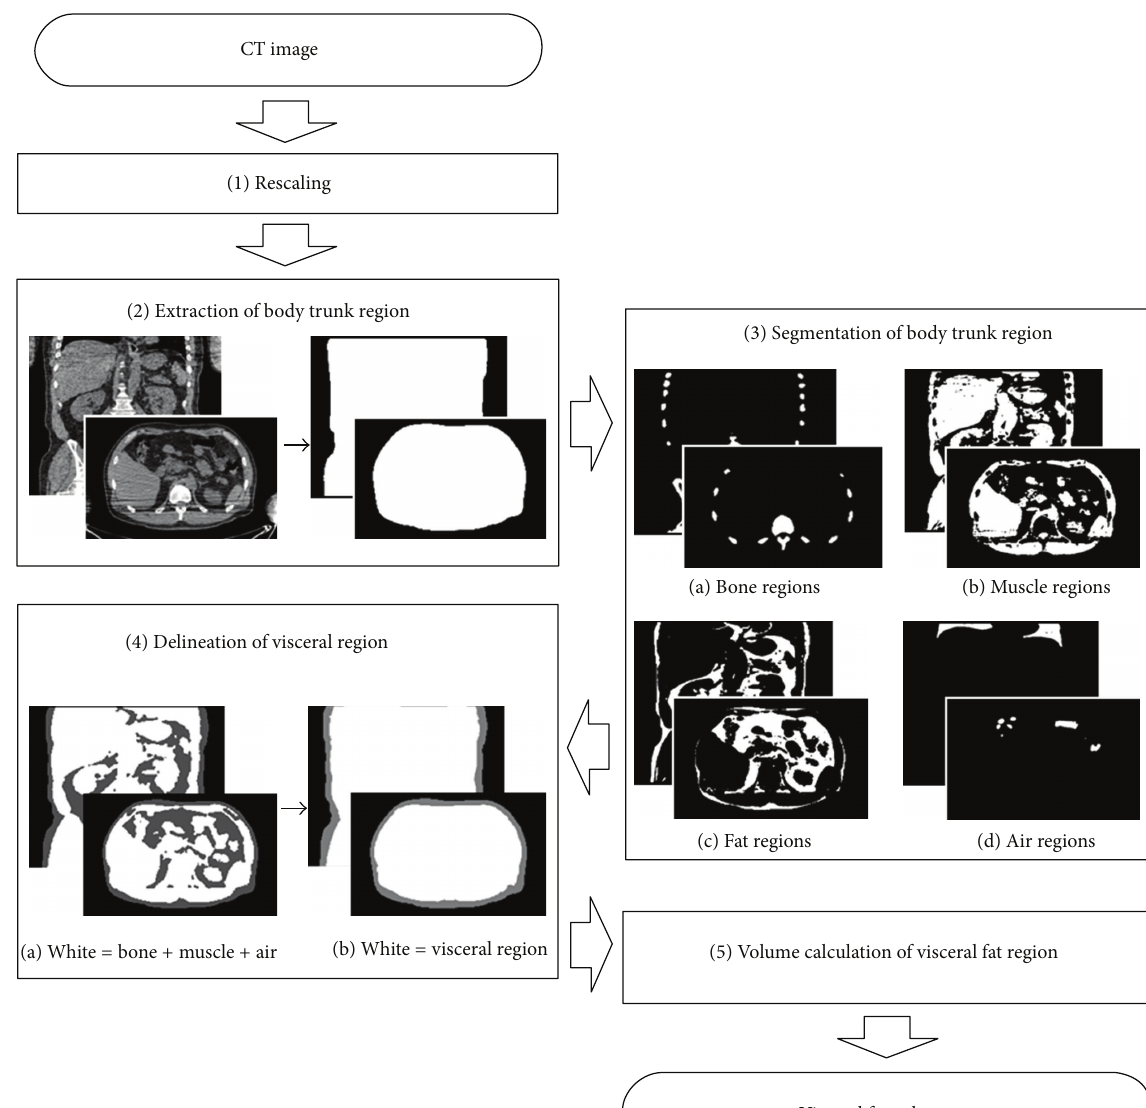
Figure 1: Flowchart of proposed fat volume calculation